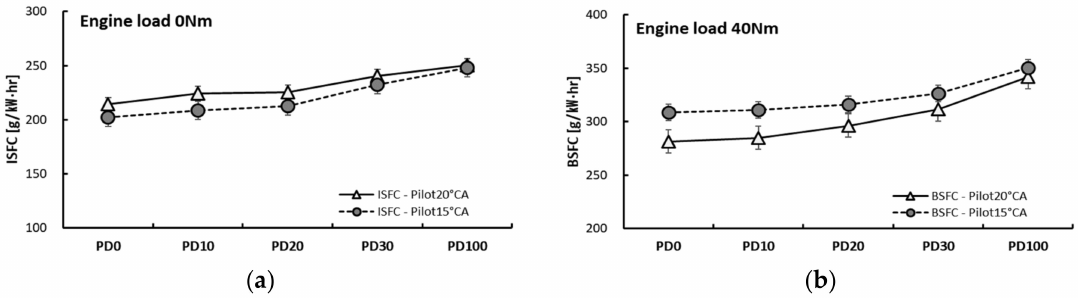
Figure 5. Specific fuel consumption: ( a ) ISFC of engine load 0 Nm ( b ) BSFC of engine load 40